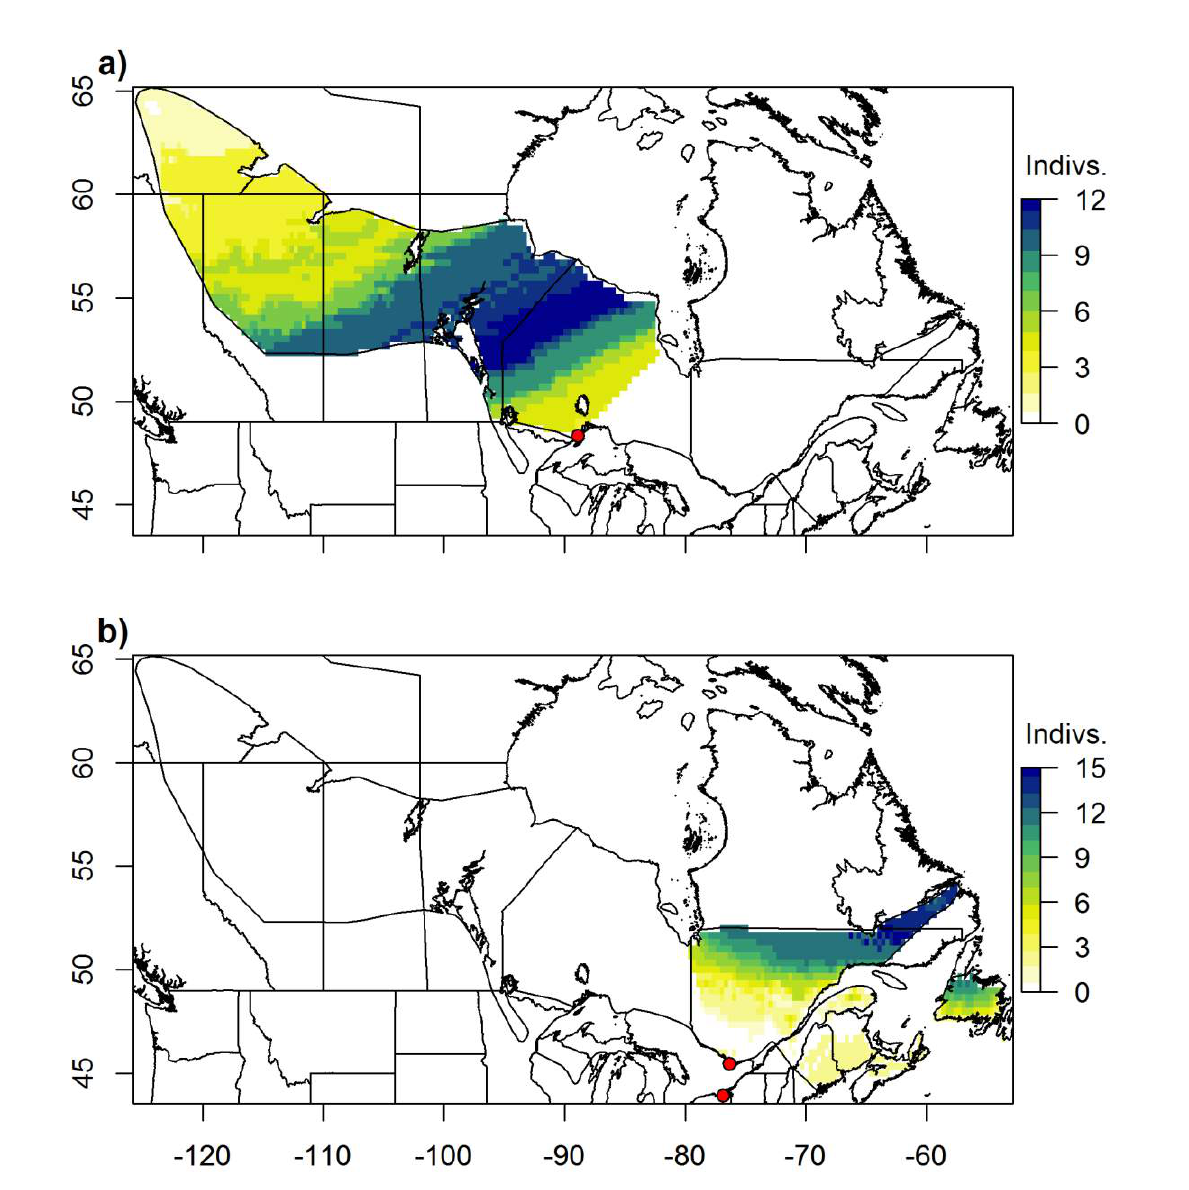
Figure A2.17: Probable origins of Palm Warblers ( Setophaga palmarum ) captured during spring migration at CMMN stations in a) Western Ontario (TCBO (n=20)) and b) Southeast Ontario & Southwest Québec (IPBO (n=3), PEPTBO